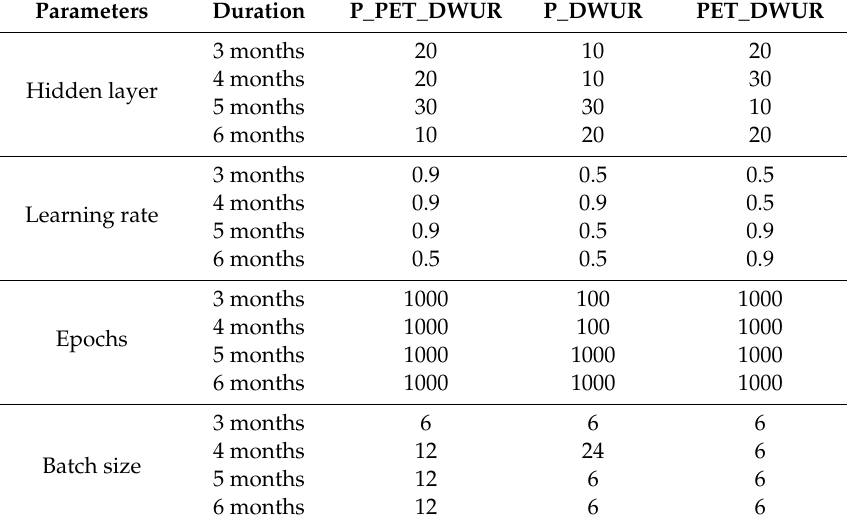
Table 2. Optimal parameters of the deep belief network (DBN).